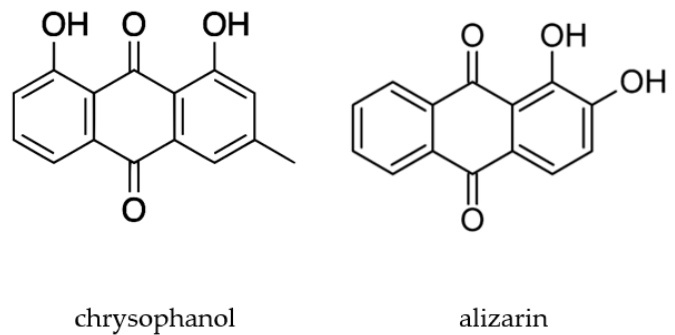
Figure 1. The natural antra-quinones.